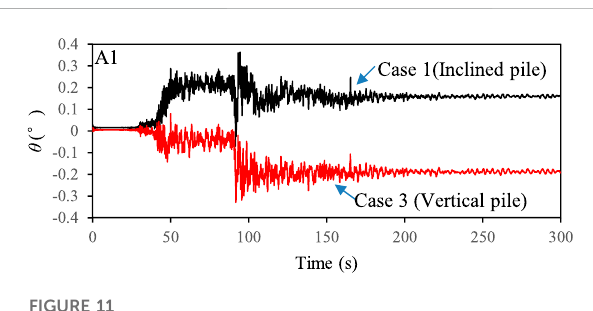
FIGURE 11 Effect of the pile rake angle on the rotation of the A1 abutment.